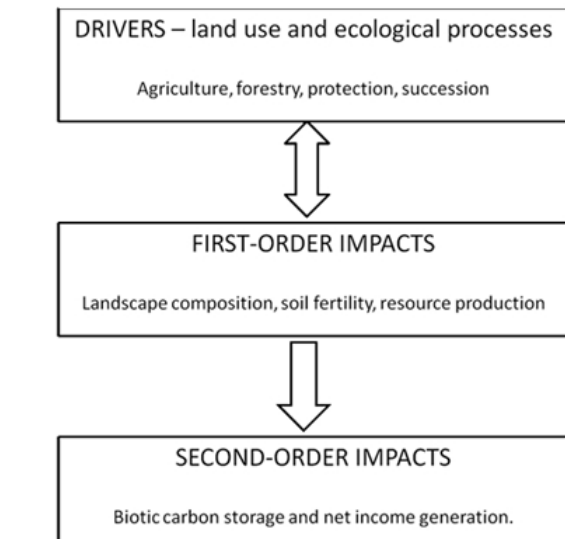
Fig. 2 . Simulation model overview. The model tracks changes in landscape composition, soil fertility, and resource production in response to simulated land use trajectories. In turn, changes to landscape composition and fertility as well as succession affect future land use patterns. Simulated changes to landscape composition and resource production are used to calculate second-order impacts, including biotic carbon storage and net income